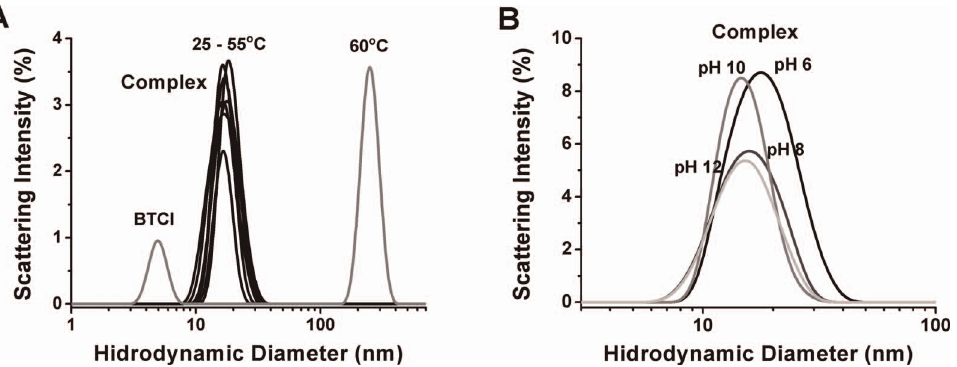
Figure 2. Dynamic Light Scattering size distribution of BTCI-proteasome complex. A) Hydrodynamic diameter of the BTCI-proteasome complex as a function of temperature and B) pH. The complex appears as a stable protein until 55 u C but dissociates and forms BTCI as a trimer and the proteasome as an aggregate up to 60 u C. The conformational changes in the complex were observed as a function of pH, as indicated by the differences in hydrodynamic diameter.